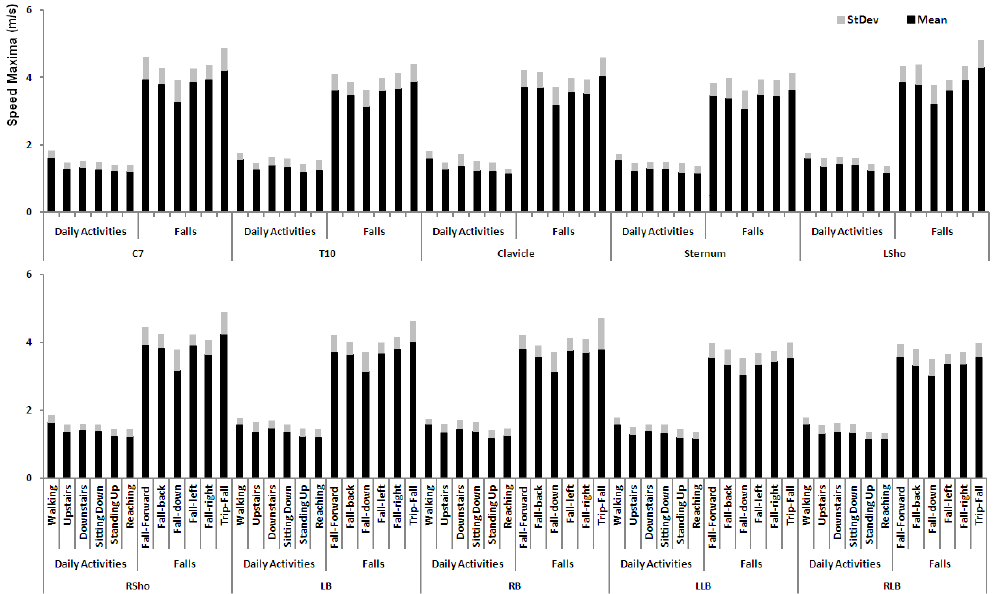
Figure 7. Speed maximum (mean and StDev [standard deviation]) at each marker of interest for daily activities and fall